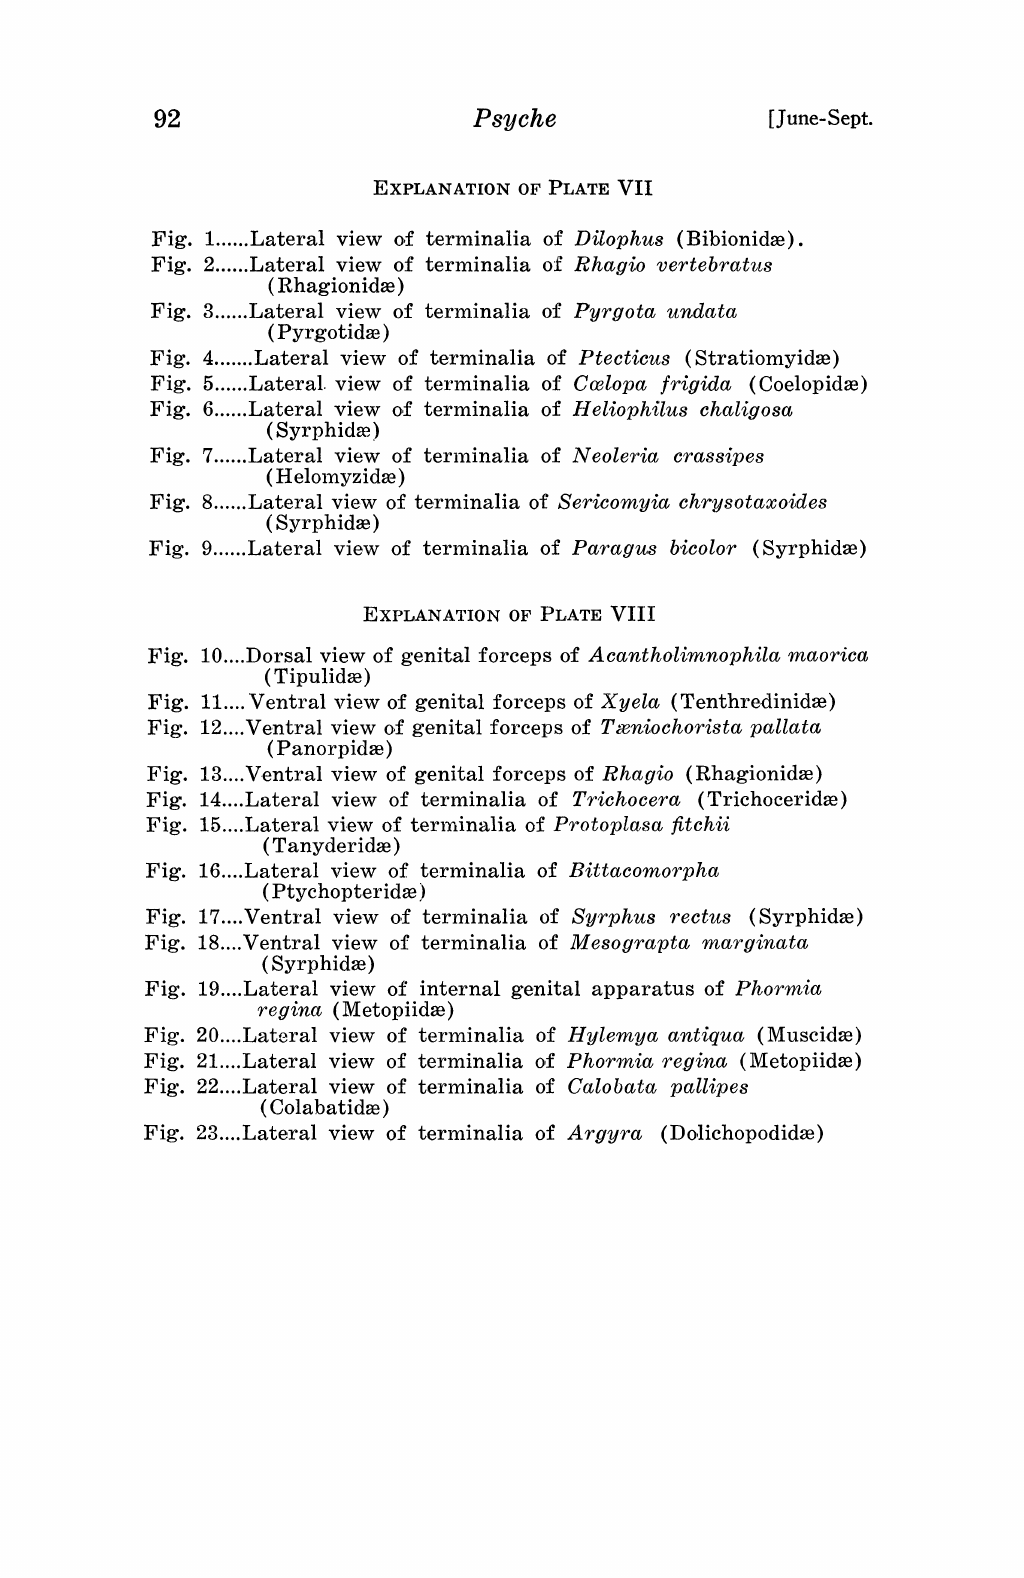
Lateral. view of terminalia of Clopa frigida (Coelopidm) Lateral view o.f terminalia of Heliophilus chaligosa (Syrphidm) Lateral view of terminalia of Neoleria crassipes (He,lomyzide) Fig. 8 Lateral view of terminalia of Sericomyia chrysotaxoides (Syrphidse) Fig. 9 Lateral view of terminalia of Paragus bicolor (Syrphidm) EXPLANATION OF PLATE VIII 10 Dorsal view of genital forceps of A cantholimnophila maorica (Tipulidm) 11 Ventral viev of genital forceps of Xyela (Te,nthredinidm) 12 Ventral view o.f genital forceps of Tvniochorista pallata (Panorpidm) 13 Ventral view of genital forceps of Rhagio (Rhagionidm) 14 Lateral view of t,erminalia of Trichocera (Trichoceridm) 15 Lateral vi,ew of terminalia of ProtopIasa fitchii (Tanyderidm) 16 Lateral view of terminalia of Bittacomorpha (Ptychopt,eridm) 17 Ventral view o.f terminalia of Syrphus rectus (Syrphide) 18 Ventral view of terminalia of Mesograpta marginata (Syrphidm) 19 Lateral view of internal genital apparatus of Phormia regina (Metopiidm) 20 Lateral view of terminalia of Hylemya antiqua (Musci,dm) 21 Lateral view of terminalia o,f Phornia regina (Metopiidm) 22 Lat,eral view of terminalia of Calobata pallipes (Colabatidm) 23 Lateral view of terminalia of Argyra